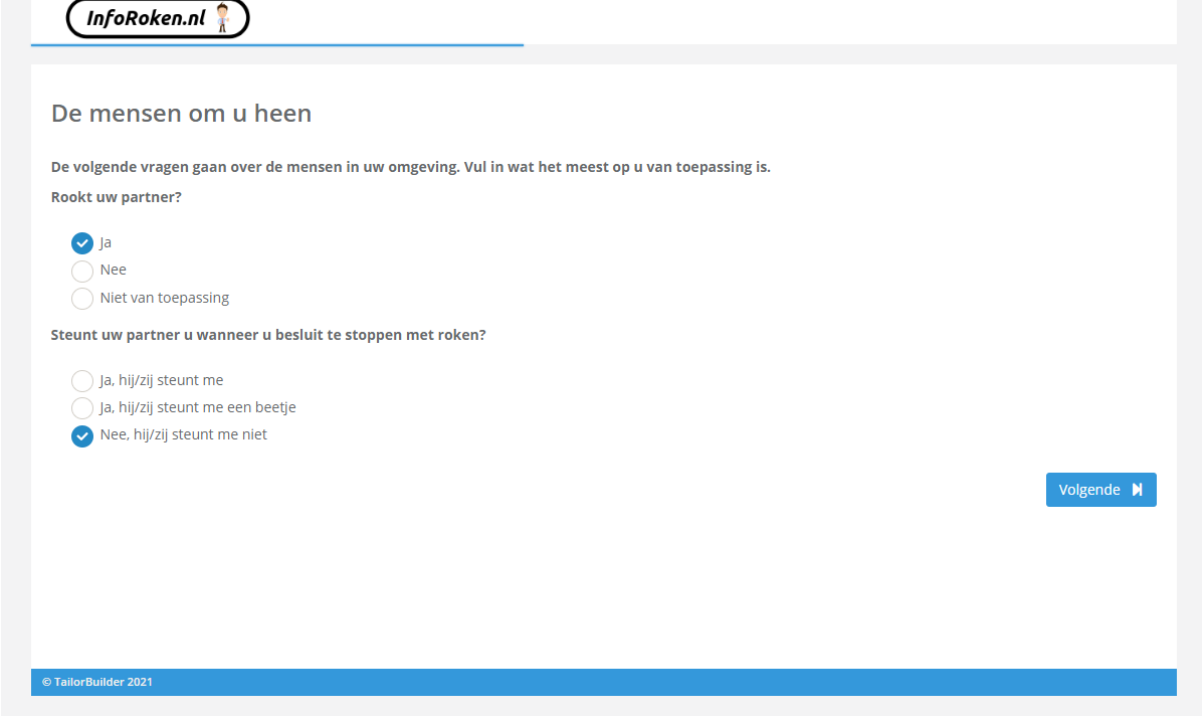
Figure 5. Screenshot of a webpage of the intervention showing 2 questions with answer